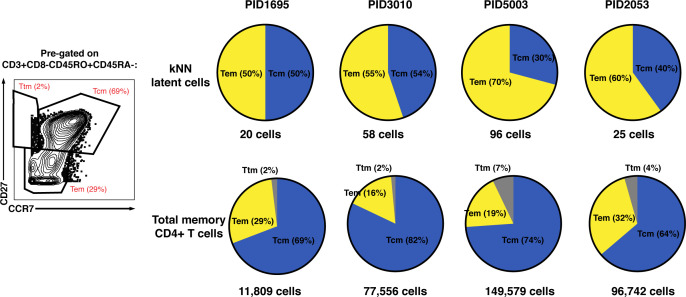
Distribution of Tcm, Tem, and Ttm among kNN latent cells and total memory CD4+ T cells.Shown on the left is the gating strategy used to identify the Tcm (CCR7+CD27+), Tem (CCR7-CD27-), and Ttm (CCR7-CD27+) subsets, implemented on cells from PID1695. Cells were pre-gated on live, singlet CD3+CD8-CD45RO+CD45RA- cells. Shown on the right are the percent of kNN latent cells (top) or total memory CD4+ T cells (bottom) belonging to the Tcm, Tem, and Ttm subsets. Tem cells were over-represented among kNN latent cells relative to total memory CD4+ T cells. The numbers below the pie graphs correspond to the number of kNN latent cells or total memory CD4+ T cells in each sample.